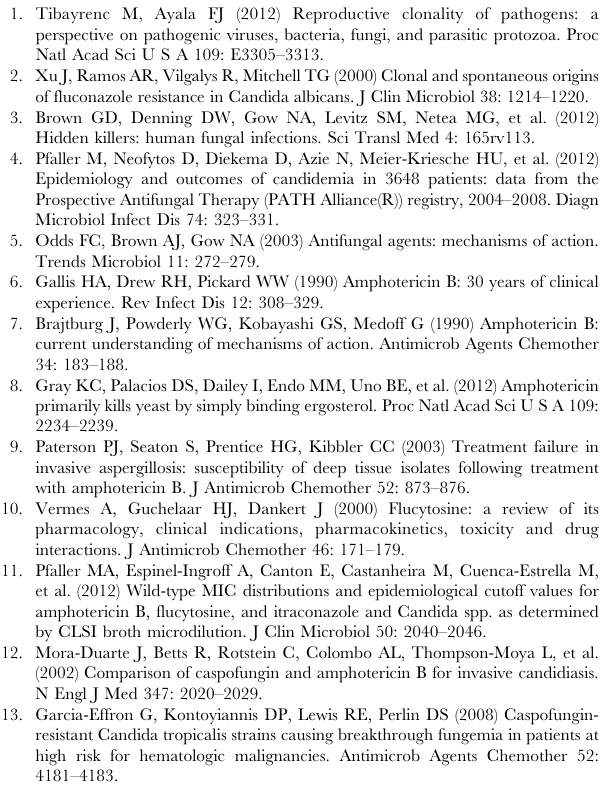
Figure S5 Validation of additional mutant strains. (A) AmB susceptibility of a second, independently generated labora- tory deletion mutant in ERG2 , ERG6 , or ERG3 and ERG11 , performed as described in Figure 1D. (B) Sensitivity of each additional mutant to hypochlorous acid (B) and DPTA NONOate (C), performed and analyzed as described in Figure 4B–C (** p , 0.01, Student’s t test). (D) Filamentation of each additional mutant in response to stimulation by fetal bovine serum at 37 u C in RPMI media, performed as described in Figure 5A. Table S1 Strains. List of strains used in this study. Table S2 Oligonucleotide sequences. Oligonucleotide primer sequences used in the generation of mutants and RT- PCR